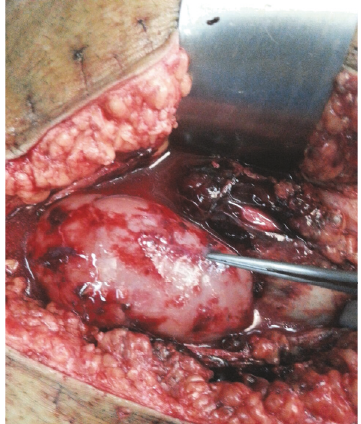
Figure 1: Two ruptures, 10cm and 5cm one at upper pole and one at midportion,